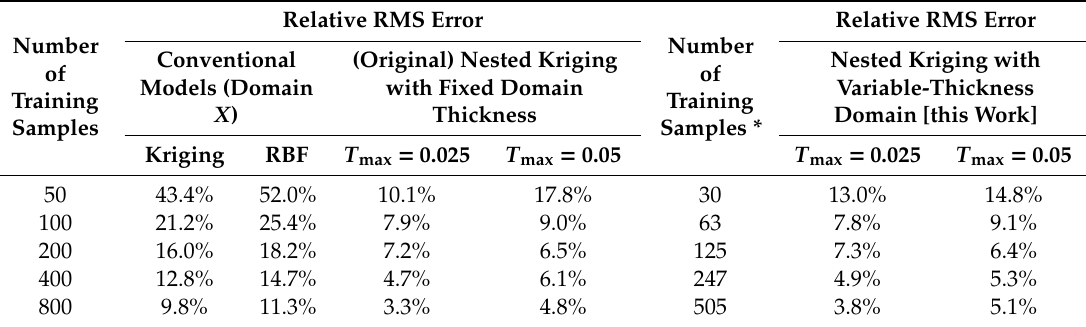
Table 2. Modeling Results for Antenna of Figure 11.